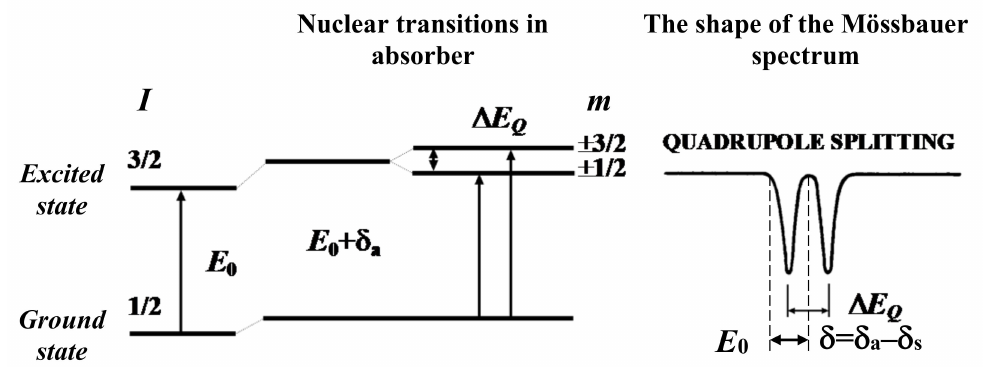
Figure A6. The scheme of the nuclear electric monopole and quadrupole interactions, isomer shift δ and quadrupole splitting ∆ E Q for the 57 Fe, resonance transitions and resulting shape of the Mössbauer spectrum. I is a nuclear spin, m is a magnetic quantum